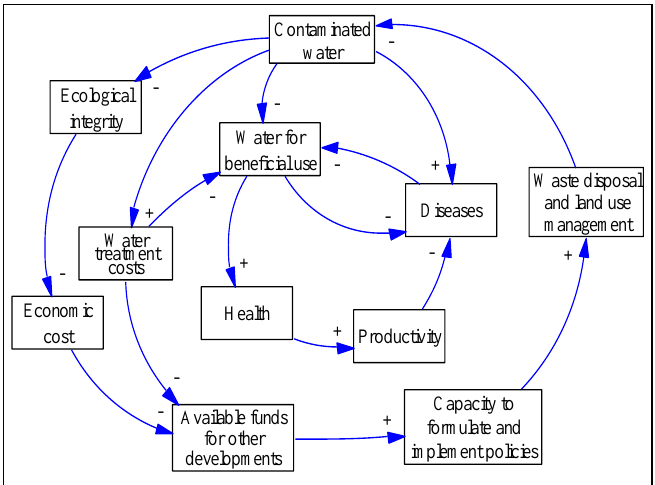
Figure 1: Causal loop on Environmental health and Economic security (The concept of adaptative sytem dynamics depicting impact of waste disposal and land management on health and economic security.